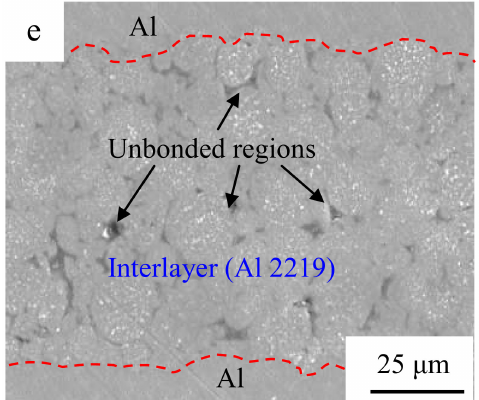
Figure 5. SEM microstructure of the cross section of the Al/Al joints with different interlayer thicknesses: ( a ) without an interlayer; ( b ) 10 µ m; ( c ) 30 µ m; ( d ) 60 µ m, and ( e ) 80 µ m.